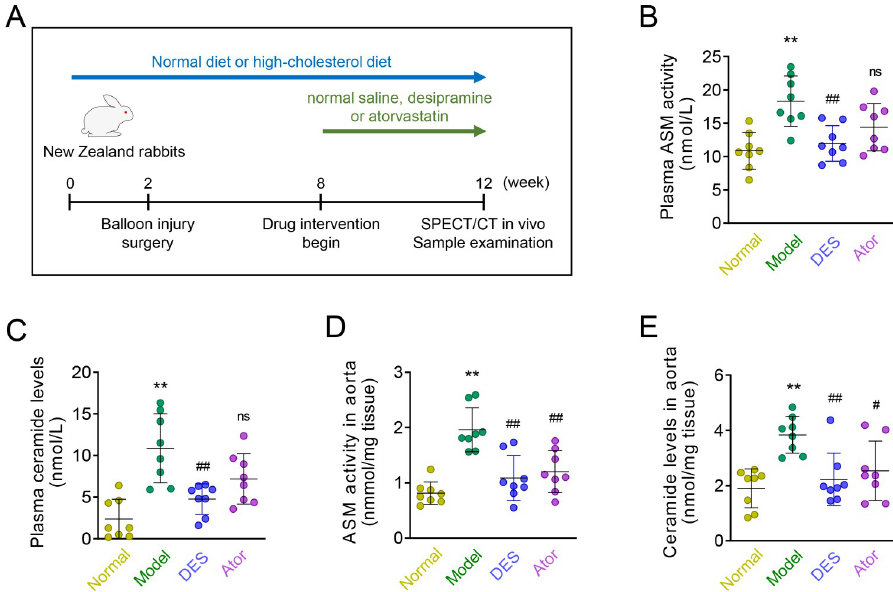
Fig 1. Desipramine and atorvastatin inhibited ASM and ceramide. (A) New Zealand white rabbits were randomly divided into four groups: Rabbits were fed on normal chow diet served as normal controls (Normal); Abdominal aorta balloon injury surgery was performed on high-cholesterol diet feeding rabbits after 2 weeks, then normal saline (Model), desipramine (DES), and atorvastatin (Ator) were administrated by gavage from 8th to 12th week. Finally, SPECT/CT and sample examination was performed. (B, C) Blood was obtained, and ASM activities and ceramide levels in plasma were determined by UPLC; (D, E) ASM activities and ceramide levels in aorta tissue were assessed by UPLC. Data are expressed as Mean ± SD, n = 8; � , �� represent P < 0.05, P < 0.01 in comparison with Normal; #, ## represent P < 0.05, P < 0.01 in comparison with Model, ns represents no-significance in comparison with